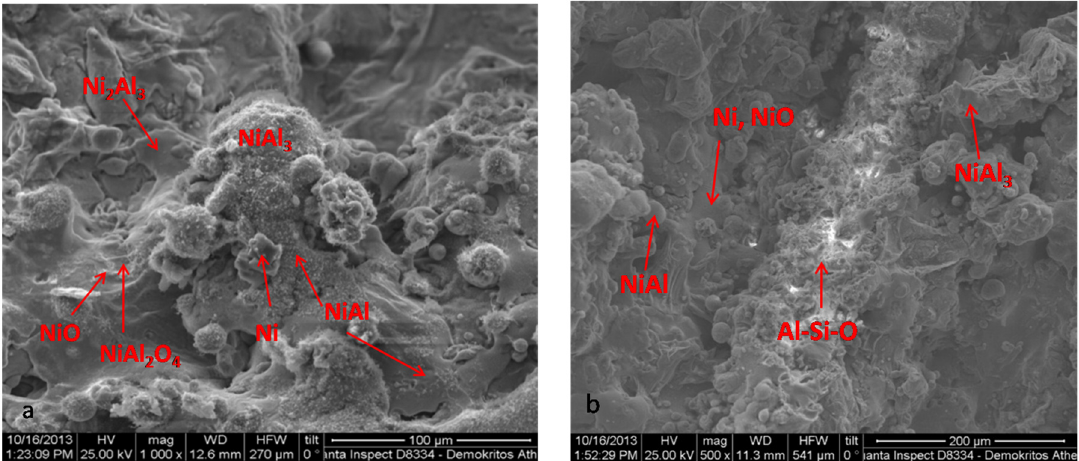
Figure 5. SEM/EDX analysis of catalytic coatings prepared by CAFSY method from initial powder mixture of 65.1% Ni + 34.9% Al (giving 4% nickel aluminides in the coating) using one gun pass on ( a ) spinel (Sp ‐ Ni65 ‐ 1) and ( b ) refractory brick (RB ‐ Ni65 ‐ 1) substrates.